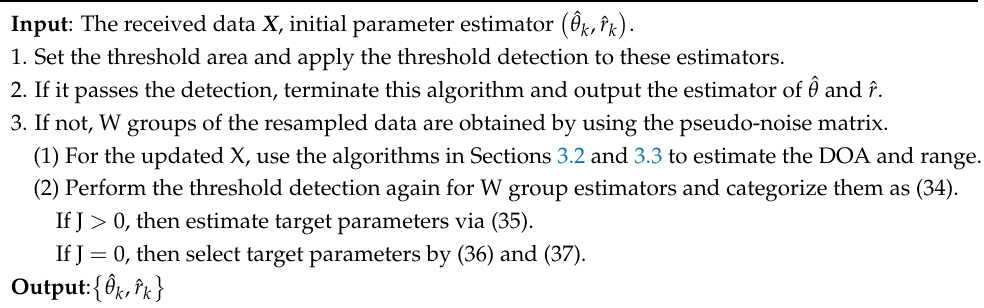
Algorithm 2 : Refined DOA–range estimation by pseudo-noise resampling.